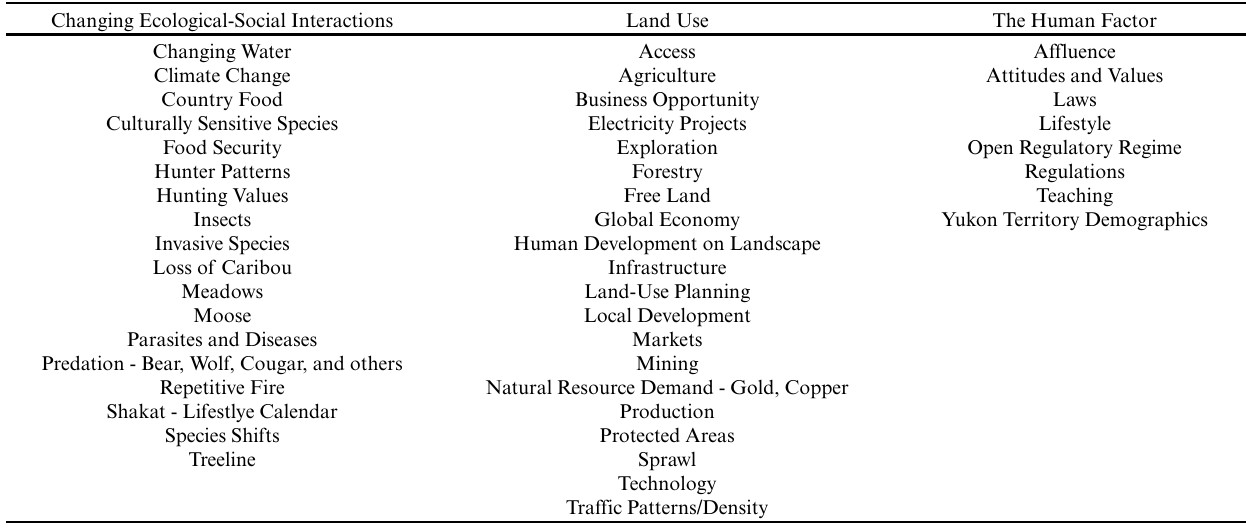
Table 2 . Drivers of change listed alphabetically and grouped by axis of uncertainty.